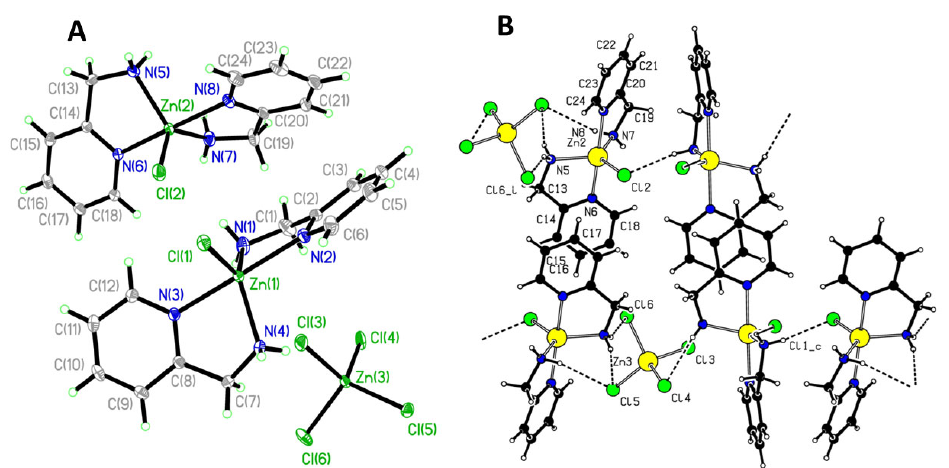
Figure 1. ( A ) Solid presentation of single crystal X ‐ ray structure of [(2 ‐ PA) 2 ZnCl] 2 (ZnCl 4 ) Zn1 , showing the labeling scheme of non ‐ hydrogen atom; ( B ) Projection along c axis, describing the geometry in the ribbons which are formed from Zn1 . Inter and intra hydrogen bonding displayed. Table 1. Selected bond lengths (Å), angles ( o ) and hydrogen bond geometry of Zn1 . Bond Lengths [Å] and Bond Angles [ o